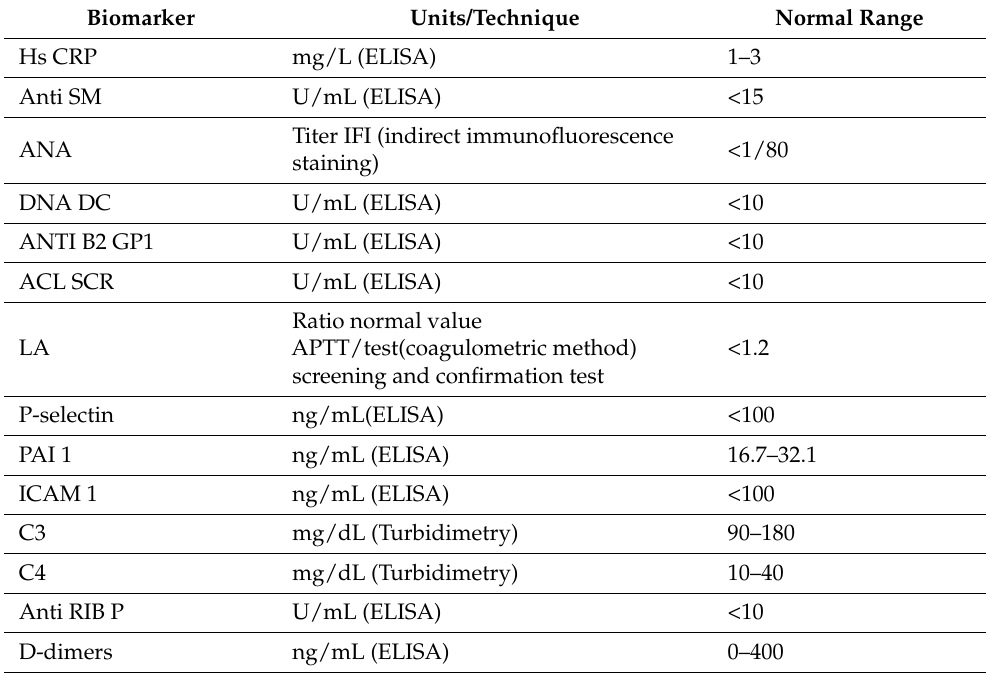
Table 1. Normal range and unit measure for the analyzed